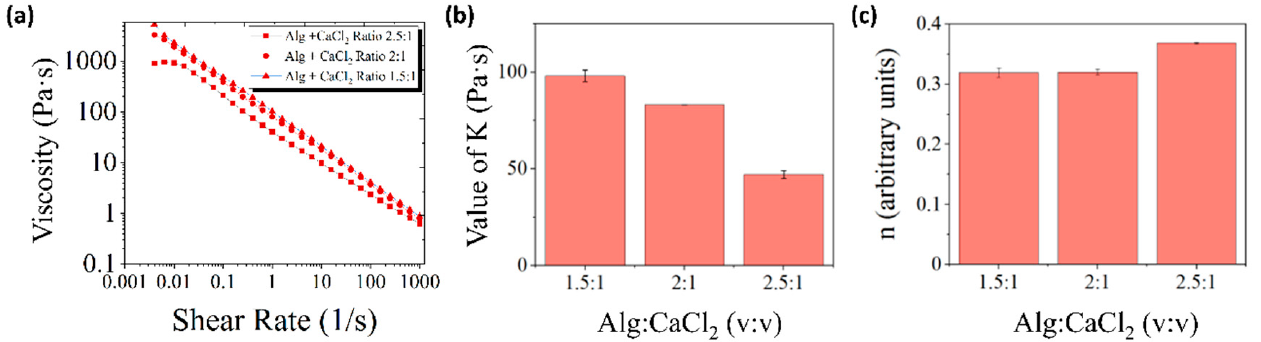
Figure 1. ( a ) The flow sweep curves of the inks with different alginate:pre-crosslinker ratios. Values of ( b ) K and ( c ) n obtained from the fitting of the viscosity curves to the Power Law equation. Viscosity curves were fitted to the Power Law model (Equation (1)) and the parameters K and n were calculated. The parameter K is simply the viscosity at a shear rate of 1 s − 1 and the parameter n is related to the slope of the viscosity curve. Inks with a higher amount of pre-crosslinker solution have higher viscosities, as proven by a greater value of K (Figure 1b), while presenting an enhanced shear thinning behavior with a lower value of n (Figure 1c). Therefore, the selected ratio of alginate:CaCl 2 was 1.5:1 for the 3D printing